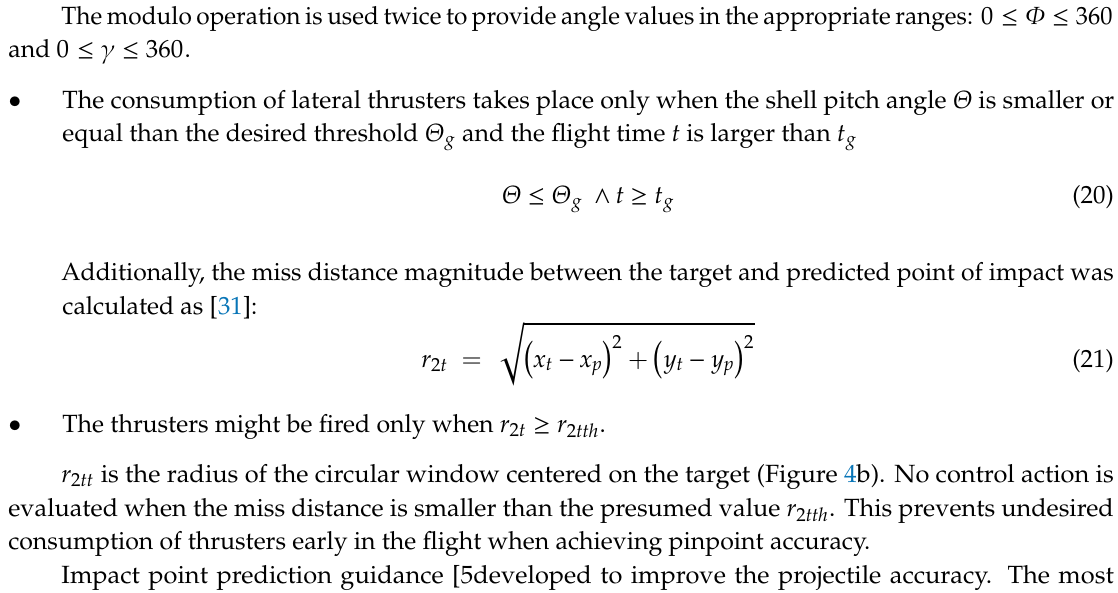
Figure 4. ( a ) Lateral thruster angular orientation; ( b ) impact point errors in the horizontal